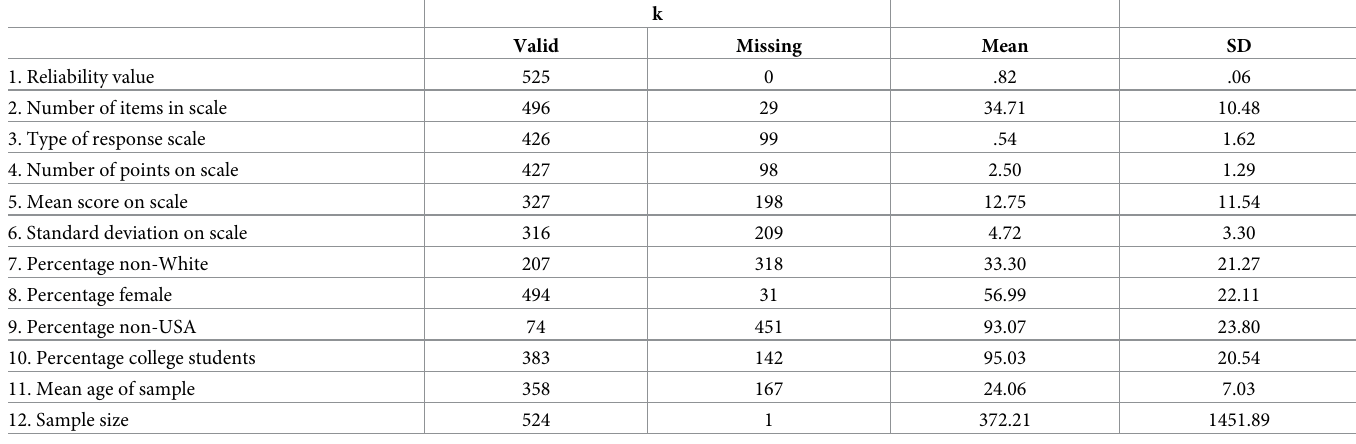
Table 2. Characteristics of coded studies for full-length Narcissistic Personality